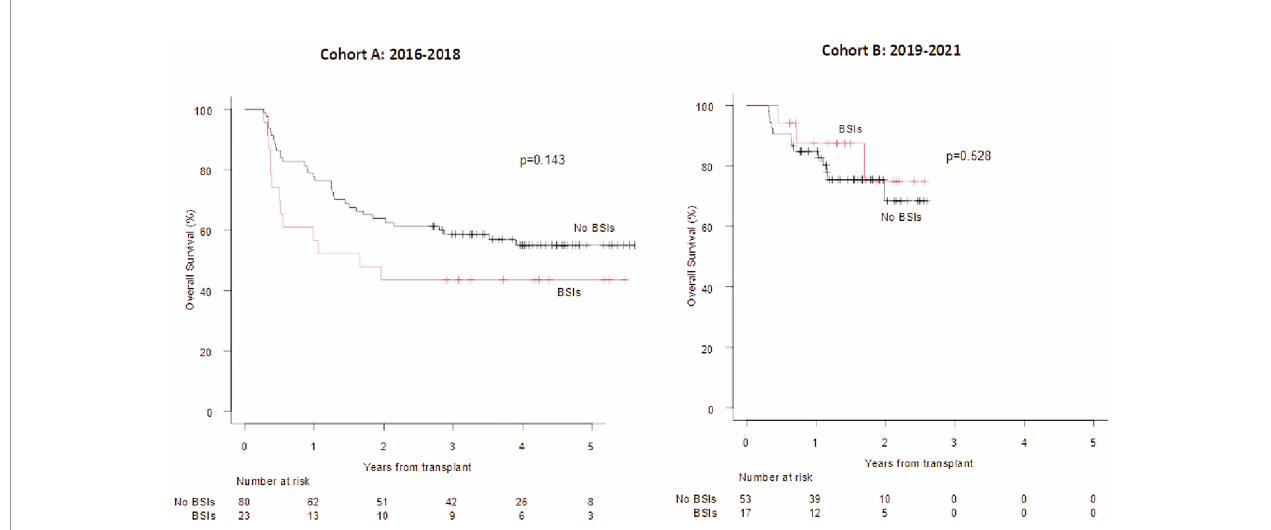
FIGURE 3 | OS according to the development of BSIs from Gram negative bacteria (+100 days Landmark analysis).OS at 1 and 2 years in case of BSIs from Gram negative bacteria vs no event (cohort A) 63.8% vs 77.5% and 43.5% vs 56.5%. OS at 1 and 2 years in case of BSIs from Gram negative bacteria vs no event (cohort B): 87.4% vs 84.9% and 74.9% vs